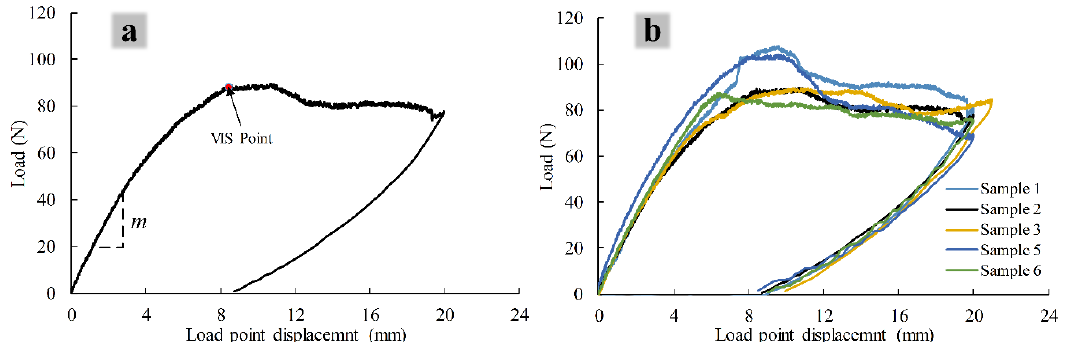
Figure 12. Load-displacement curves of MMB tests: ( a ) determination of m and P C , and ( b ) all curves of the tests.